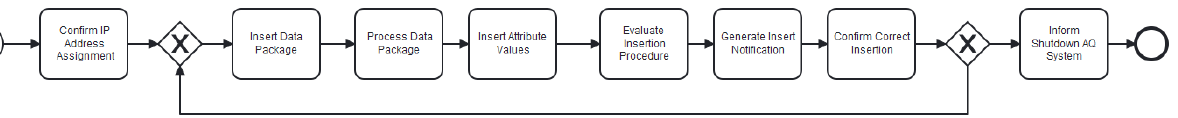
Figure 7. Process model discovered by DFG ( Repository Management Service participant).